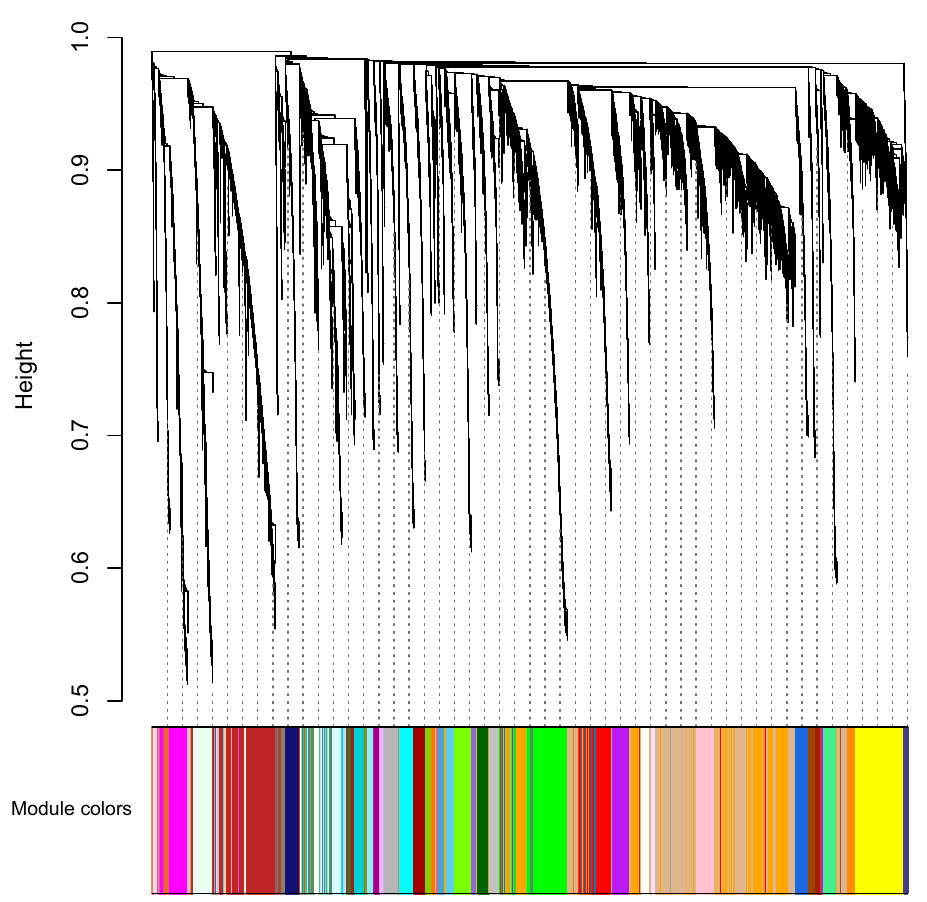
Figure 3. Clustering dendrogram. A total of 59 coexpression modules were constructed with assigned module colors at the bottom. The number of lncRNAs in the 59 modules is listed in Supplementary Materials Table S4.